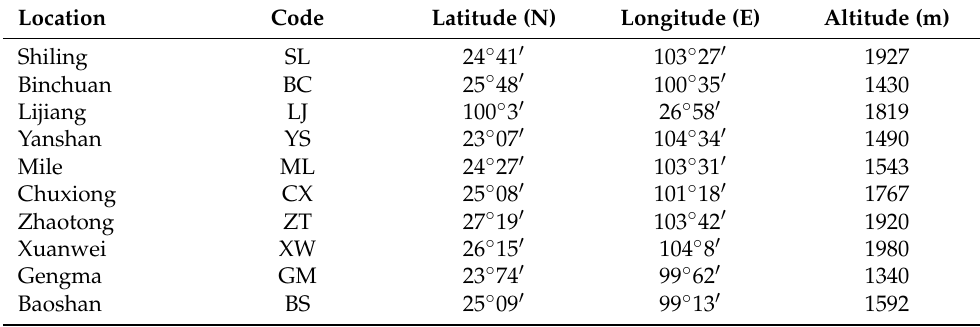
Table 2. The characteristics of test environments.